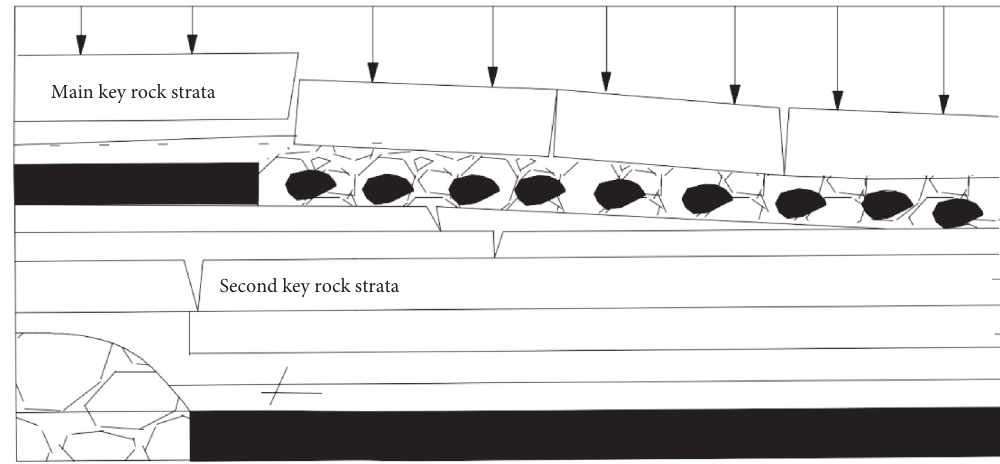
Figure 4: The roof structure when coal pillars were